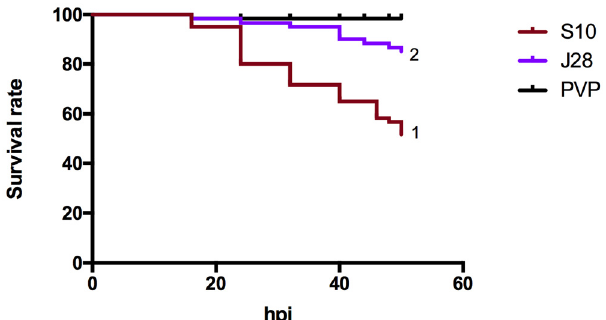
Fig 6. Relevance of the capsular polysaccharide during infection of zebrafish larvae. Survival curve of injected larvae with S . suis S10, its unencapsulated mutant strain J28 and PVP control. Larval viability was checked every 8h for the first 40h, then every 2h. (1) p < 0.001 compared with J28 and PVP control curves. (2) p < 0.01 compared with S10 and PVP control curves. Results were obtained in 3 independent experiments, and 25 larvae were injected per group.